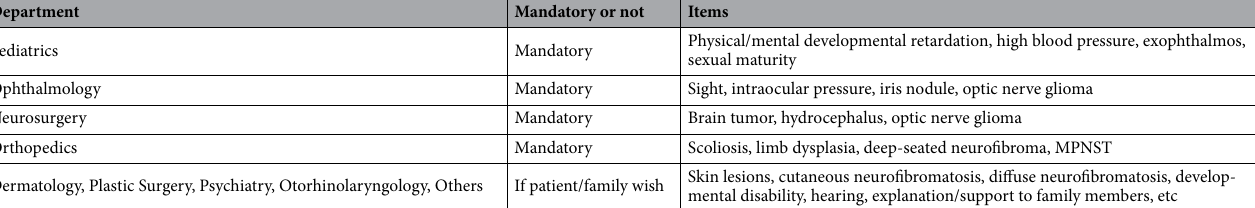
Table 1. Items to be evaluated by each department in NF1 patients up to 15 years old.